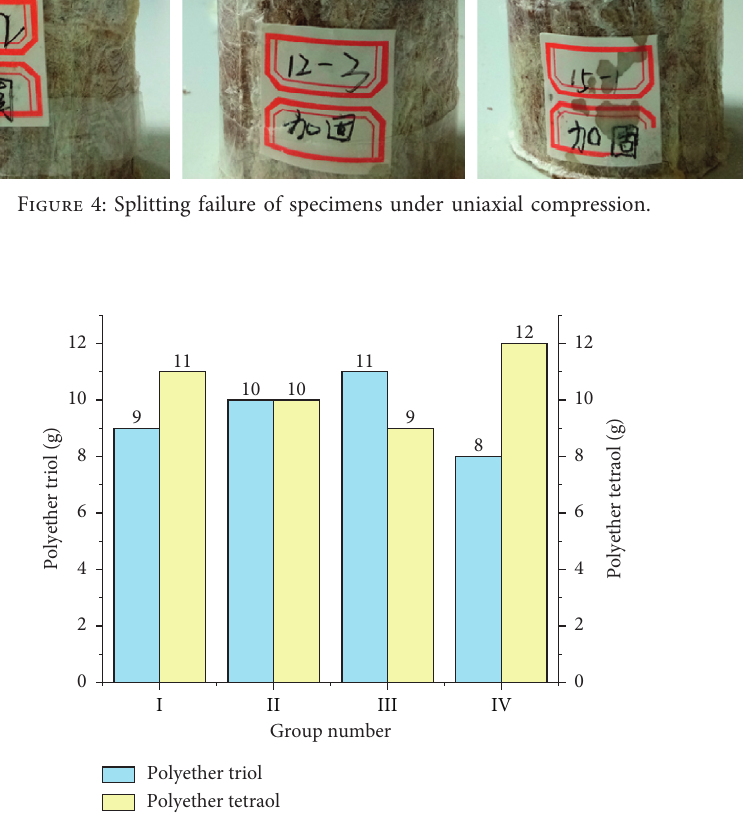
Figure 5: Dosage of polyether triol and polyether